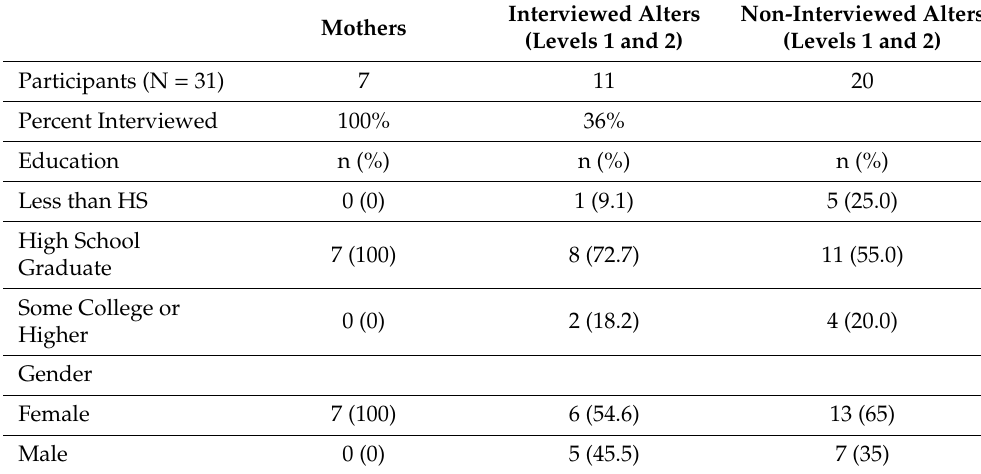
Table 1. Education and gender of all individuals in the networks. Interviewed Alters Non-Interviewed Alters Mothers (Levels 1 and 2) (Levels 1 and